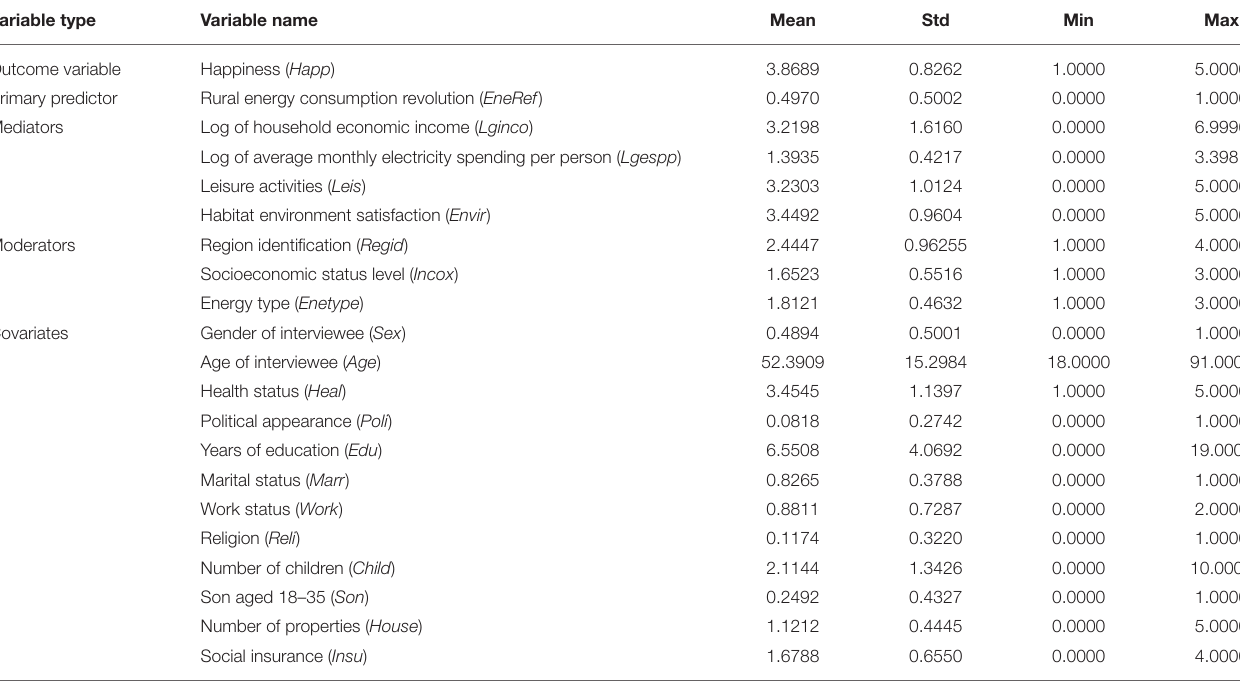
TABLE 1 | Descriptive statistics of the model variables. Variable